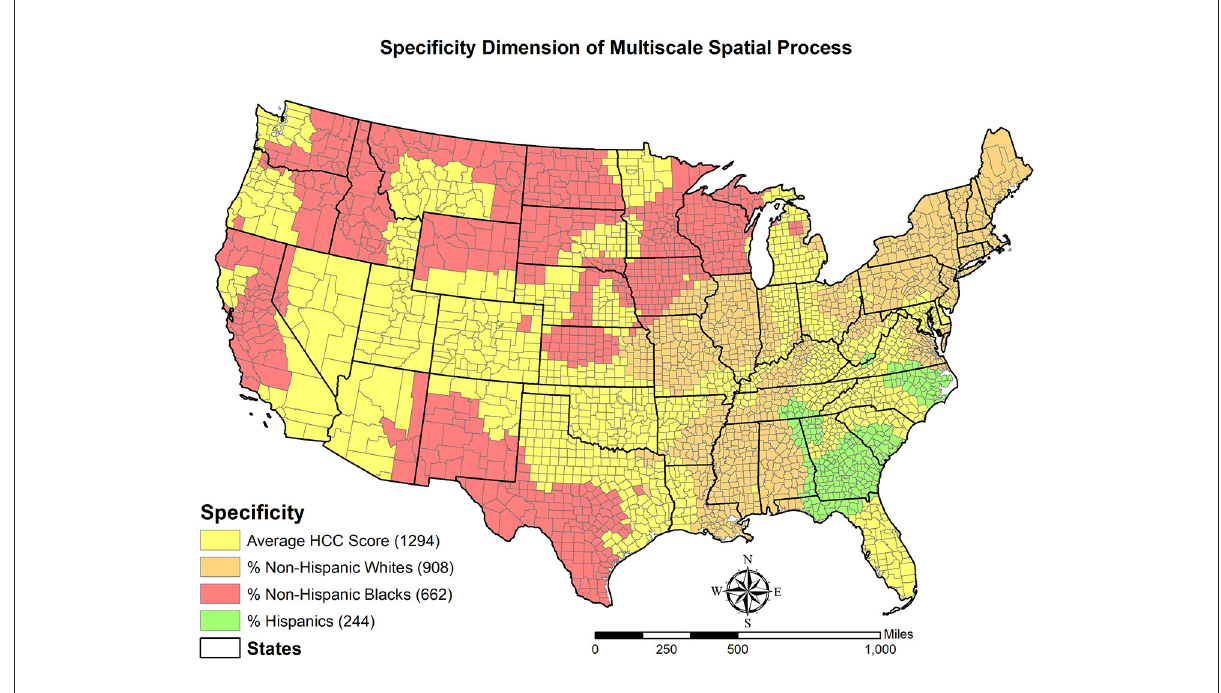
FIGURE3 Specificity dimension of multiscale spatial process.